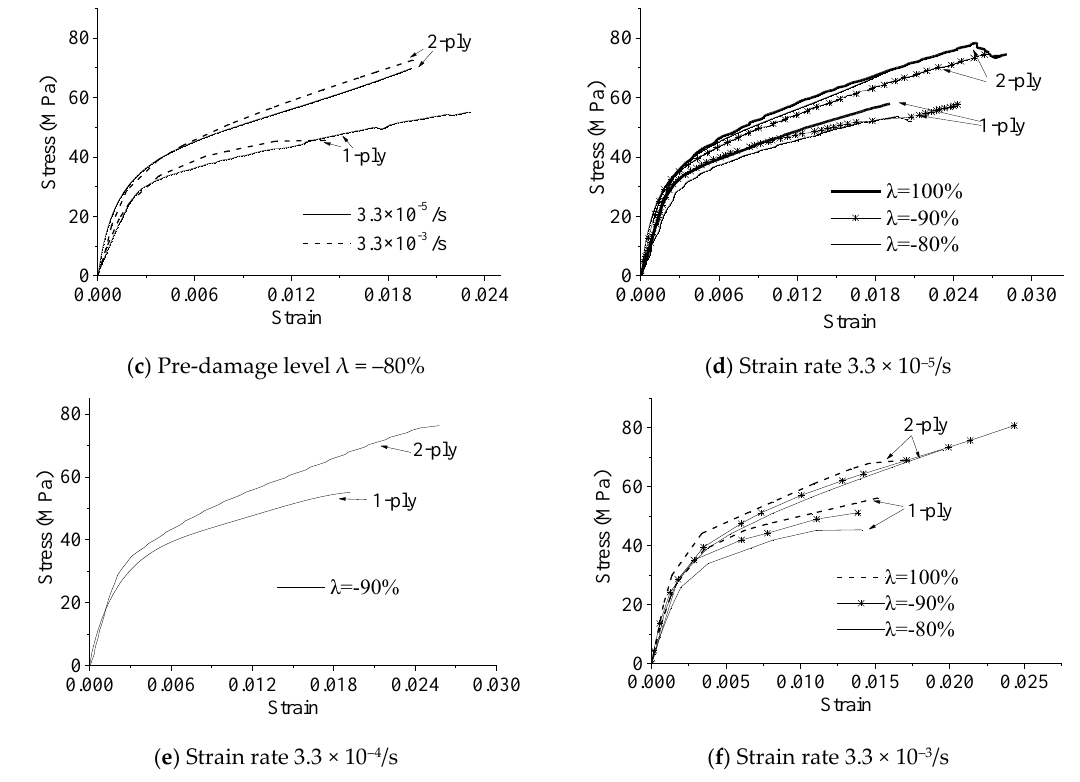
Figure 6. Effect of strain rates on the stress–strain curves. Figure 6. E ff ect of strain rates on the stress–strain